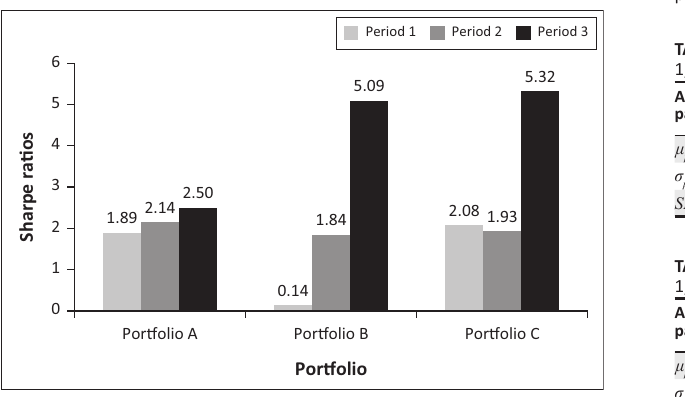
FIGURE 4: Sharpe ratios for the tangent portfolios within the different periods